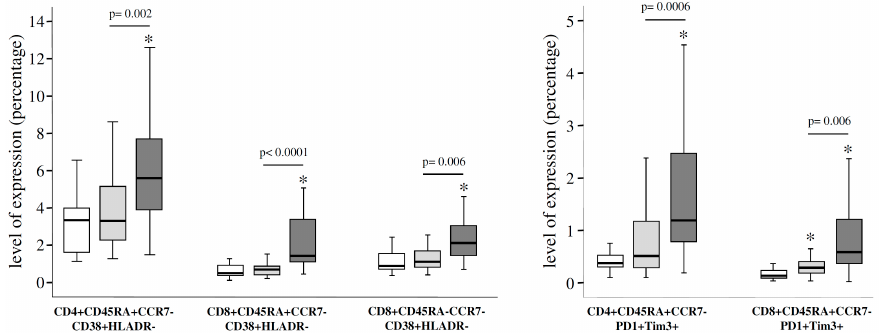
Figure 1. Box-plots showing differences in the level of expression for several CD4 and CD8 T-cell subsets between seronegative controls (white boxes), human immunodeficiency virus (HIV) monoinfected patients (light-grey boxes) and pre-direct acting antivirals (DAAs) HIV/ hepatitis C virus (HCV) coinfected patients (dark-grey boxes). p -values for the comparison between monoinfected and coinfected patients are shown. An asterisk (*) indicates significant difference ( p < 0.05) compared to seronegative controls by Mann-Whitney U test.